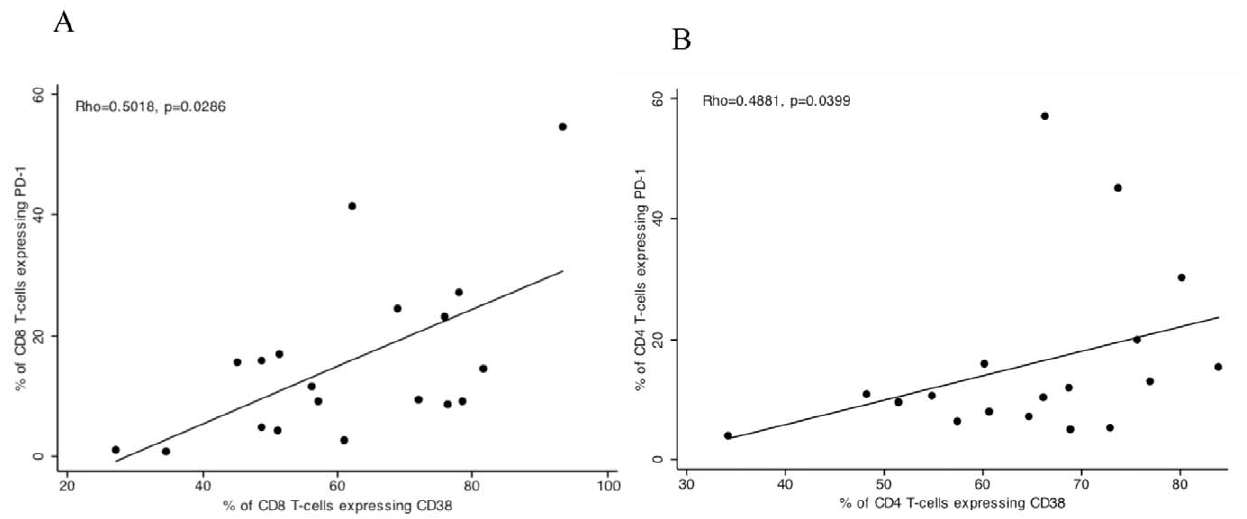
Figure 4. PD-1 expression correlates with CD38 expression during acute uncomplicated P.falciparum infection. PD-1 expression is shown on the y-axis and CD38 expression on the x- axis, each dot represents a single donor during acute (Day 0) uncomplicated P. falciparum malaria. There is a significant correlation between CD38 and PD-1 expression on CD8 + T-cells, A, and CD4 + T-cells, B.